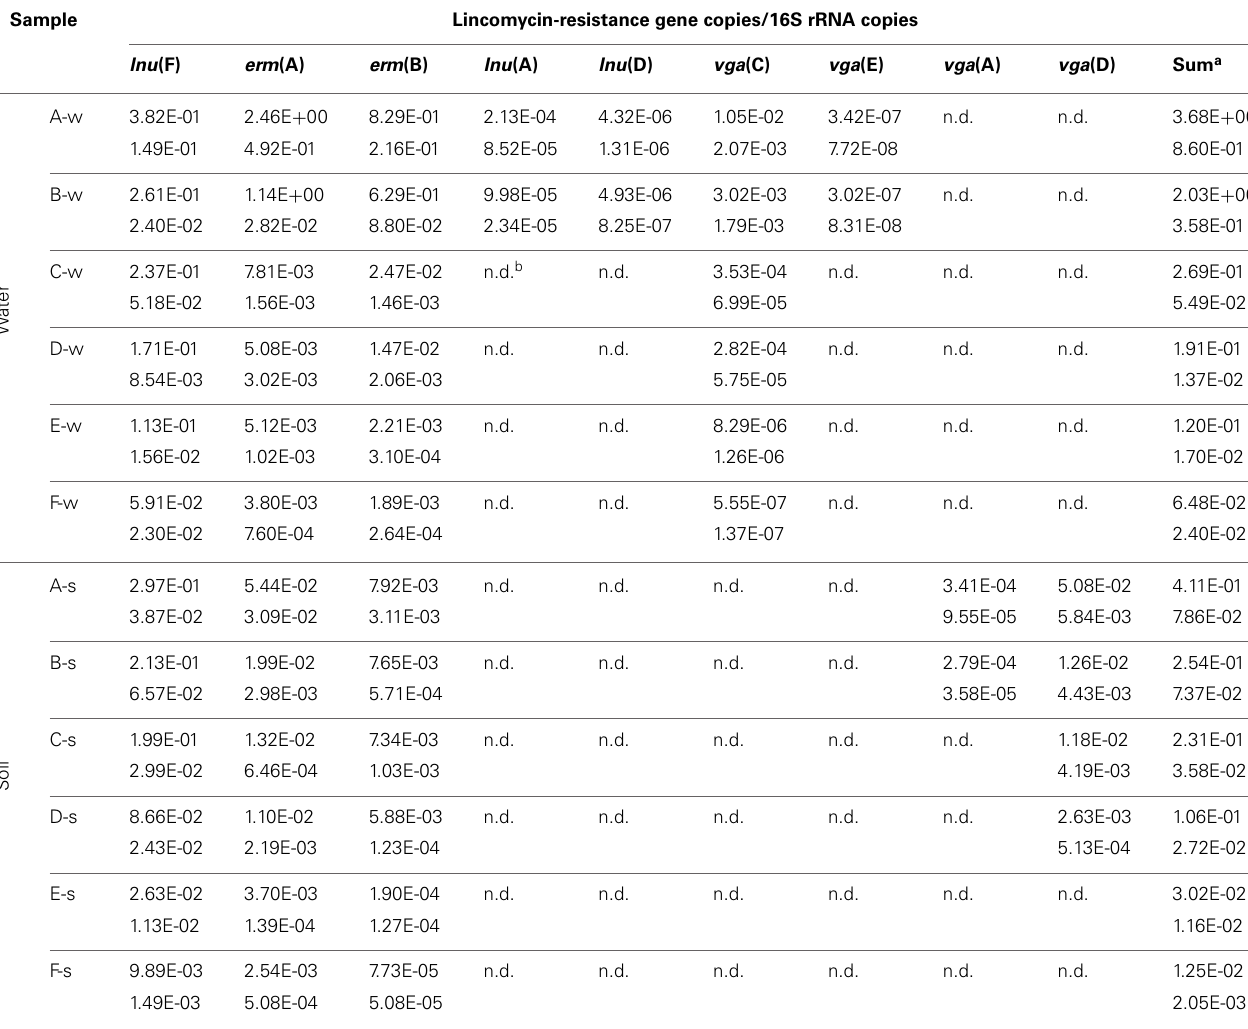
Table A3 | Relative quantification of lincomycin-resistance genes in water and soil samples, normalized to corresponding 16S rRNA